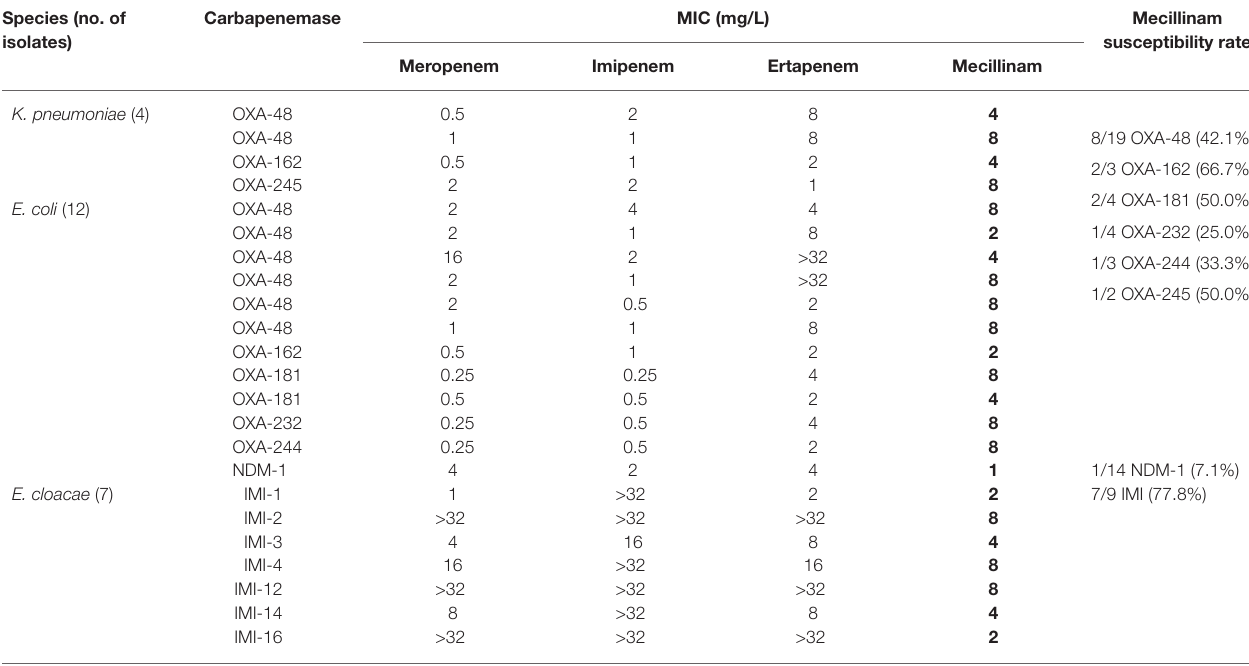
TABLE 2 | MICs for mecillinam and carbapenems of mecillinam-susceptible isolates displayed by species and carbapenemase. Species (no. of